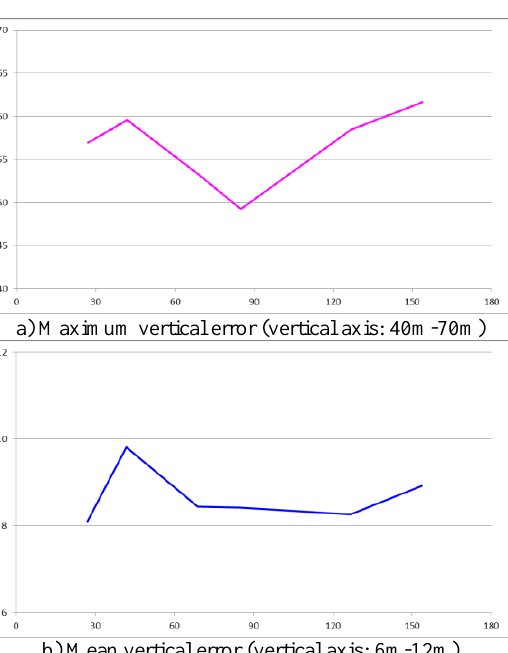
b) Mean vertical error (vertical axis: 6m-12m) Figure 8. Vertical error statistics. Horizontal axis: illumination azimuthal difference 0 o -180 o